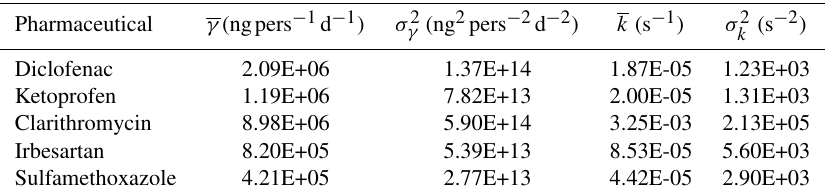
Table 3. Means ( γ , k ) and variances ( σ 2 gamma , σ 2 ) of the log-normal distributions of the unitary mass fluxes ( γ ) and of the coefficients of k decay ( k ) for the five selected pharmaceuticals. The standard deviation of the associated normal distributions, with unitary means, was set equal to 3 in order to explore several orders of magnitudes and, hence, all the plausible physical values.